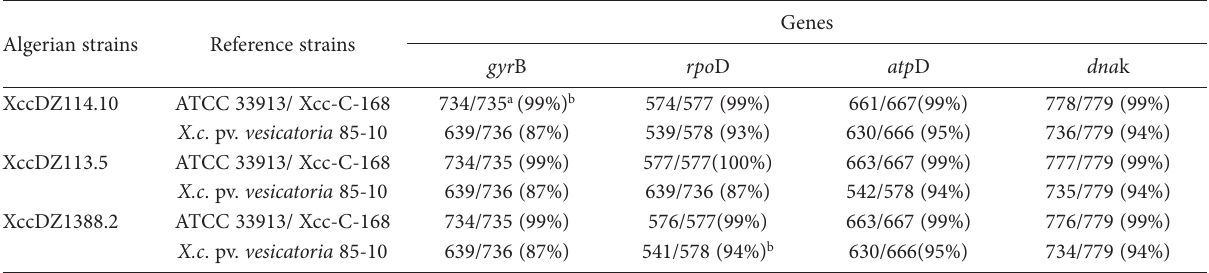
Table 3. Comparison of housekeeping gene DNA sequences of Algerian strains of Xanthomonas c ampestris pv. campestris with that of other strains of Xanthomonas campestris ( X.c. ).